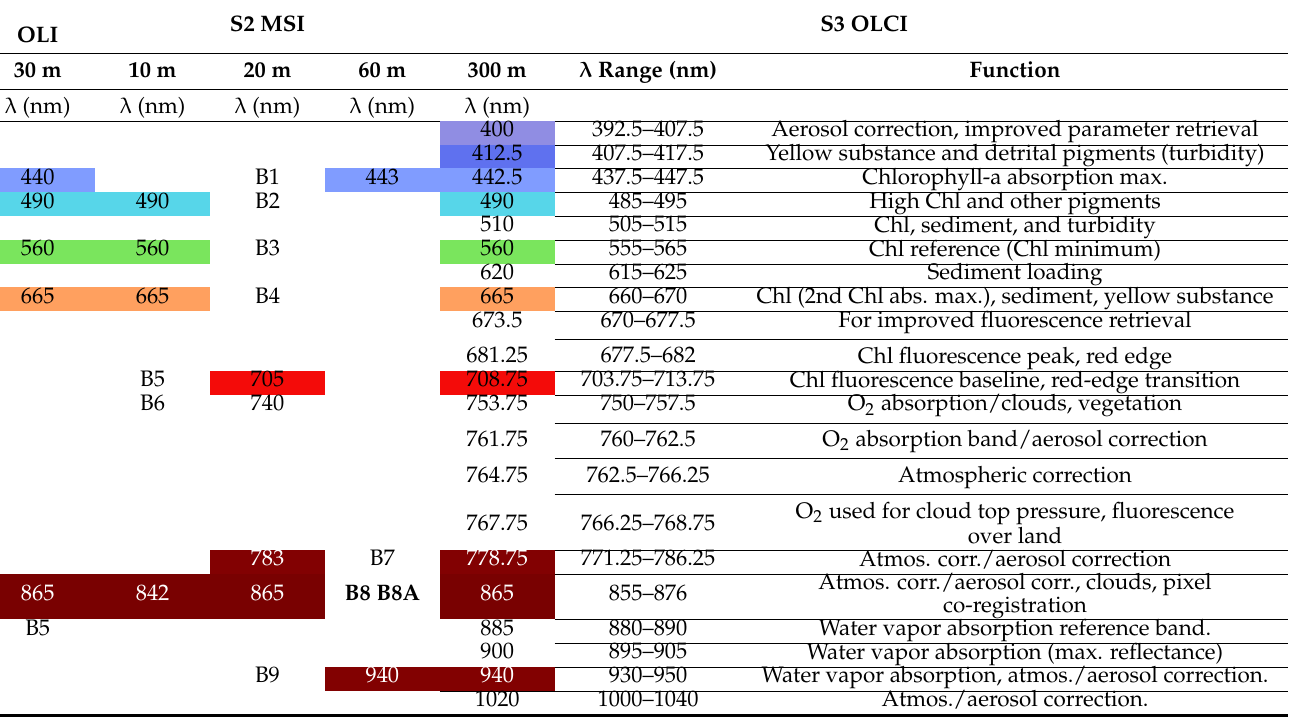
Table 2. Visible NIR spectral band characteristics of the studied data as depicted on their user hand